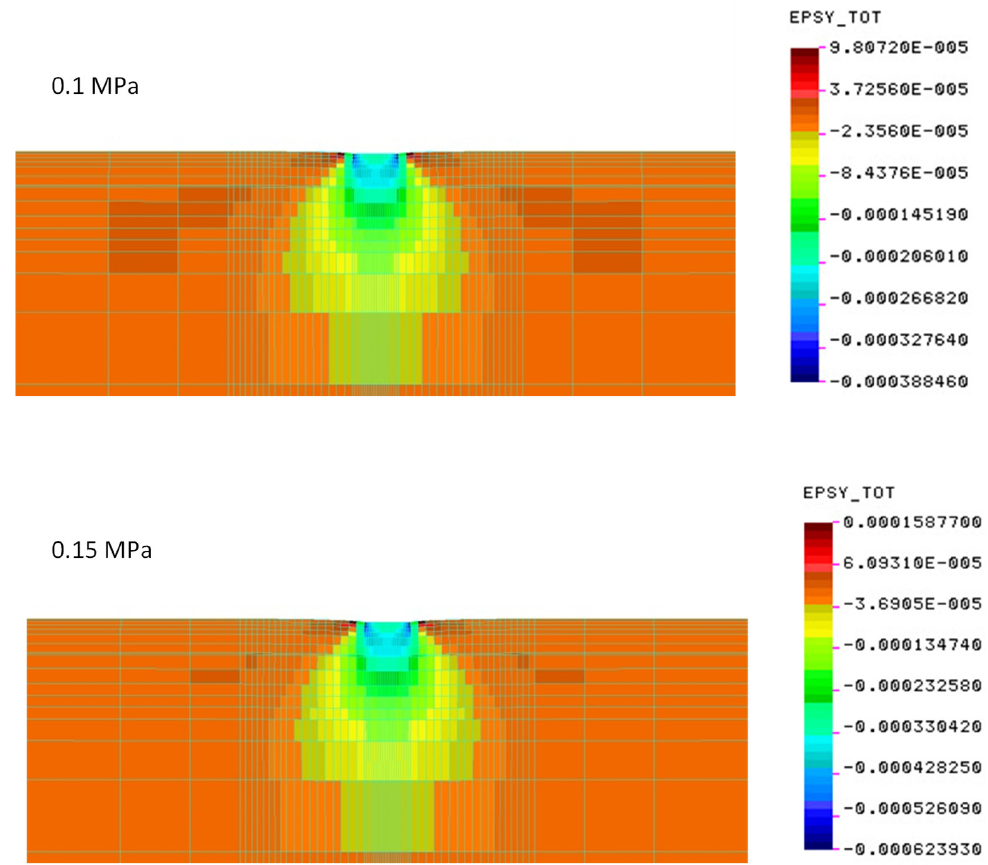
Figure 11. Deformations for crushed stone on a cement-stabilized subgrade—construction No. 1 (deformation scale ×100).